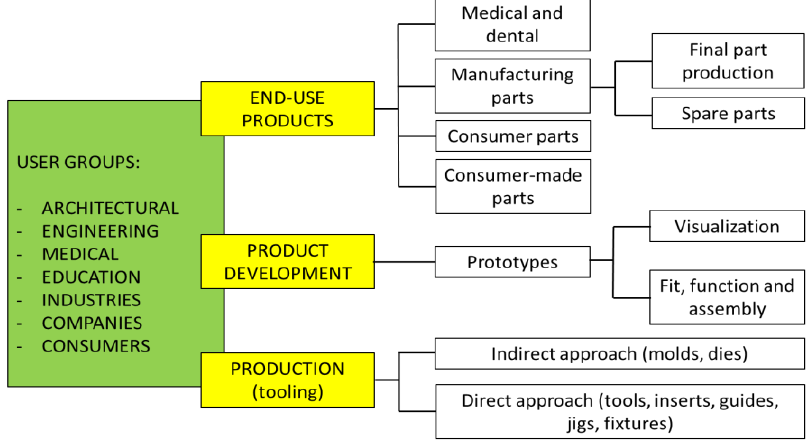
Fig. 3. Categories of AM applications and the possibilities to use them e.g. in education [1], [10],